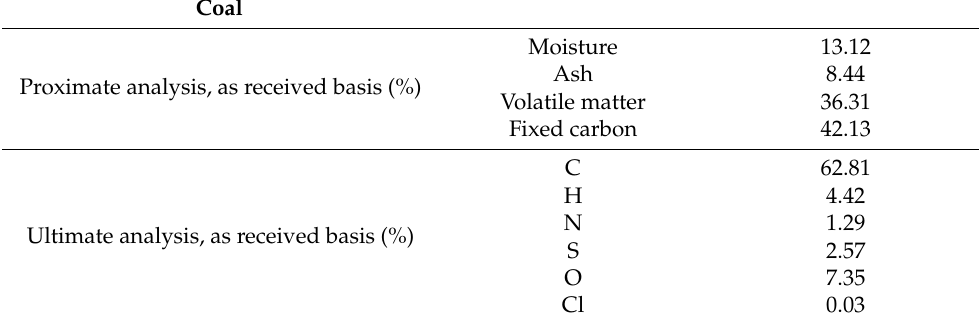
Table 1. Raw coal